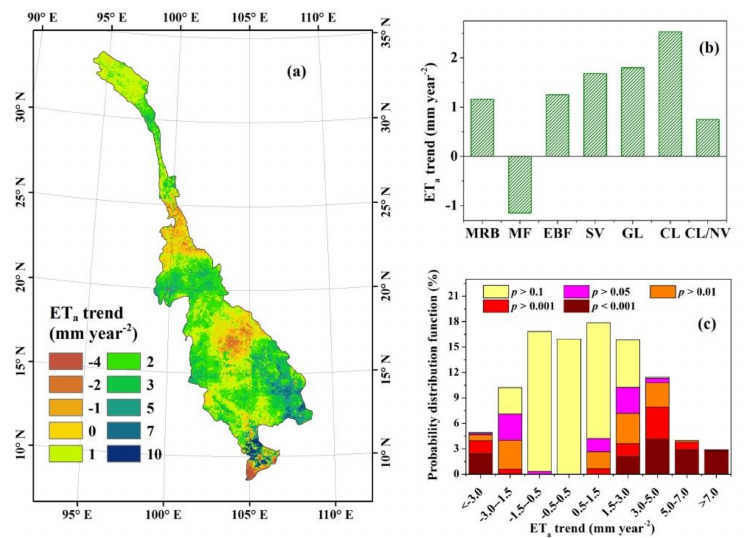
Figure 3. Spatial patterns of annual average ( a ) actual evapotranspiration, ( b ) precipitation and ( c ) potential evapotranspiration over Mekong River Basin for the period of 1981 to 2012.